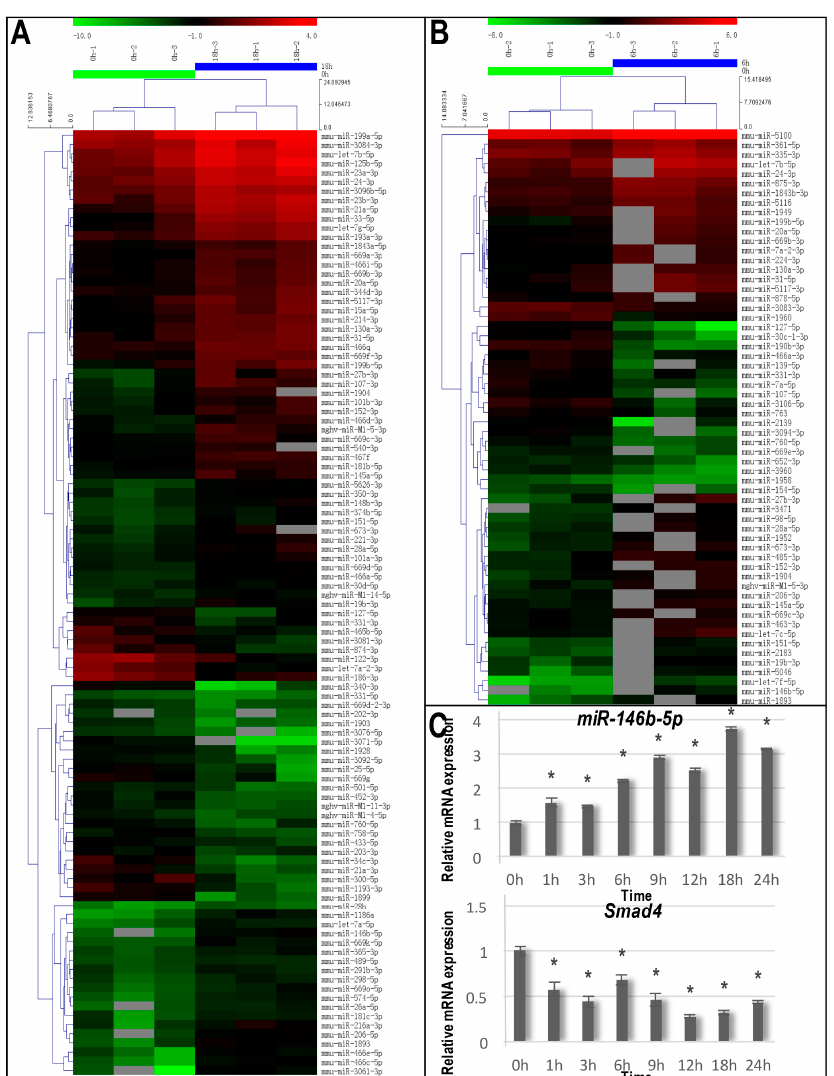
Figure 3. Identification of differentially-expressed micro-RNAs (miRNAs) stimulated by cyclic tensile stress and the qRT-PCR validation of miR-146b-5p and its target gene Smad4. ( A ) The hierarchical clustering of miRNAs differentially expressed after 18 h of tensile stress stimulation compared with the unstimulated cells; ( B ) The hierarchical clustering of miRNAs differentially expressed after 6 h of tensile stress stimulation compared with the unstimulated cells; ( C ) The graphs depicting the qRT-PCR analyses for the expression changes of miR-146b-5p and Smad4 mRNA under tensile stress stimulation for 0, 1, 3, 6, 9, 12, 18 and 24 h. * p < 0.05 in comparison with Time 0.